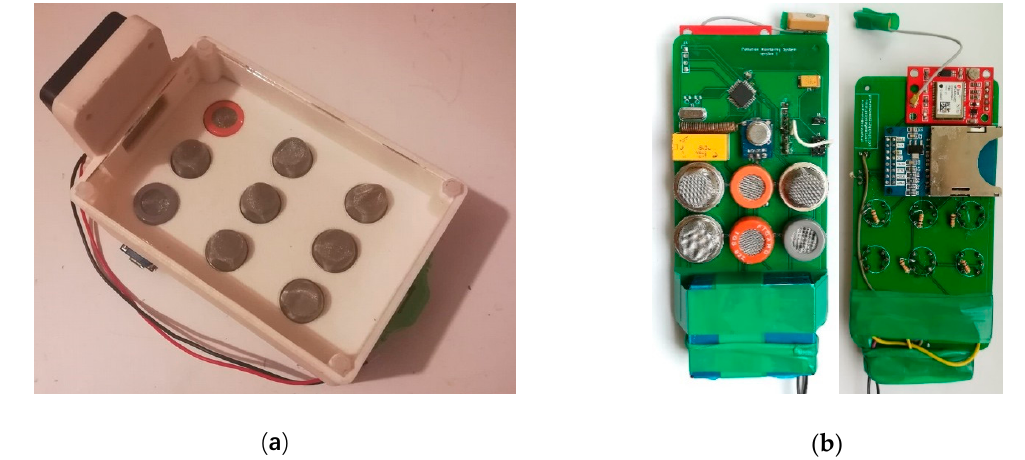
Figure 4. View of the assembled low-cost multi-sensor device in the stages of development: ( a ) prototype sensors, and ( b ) modified sensors.